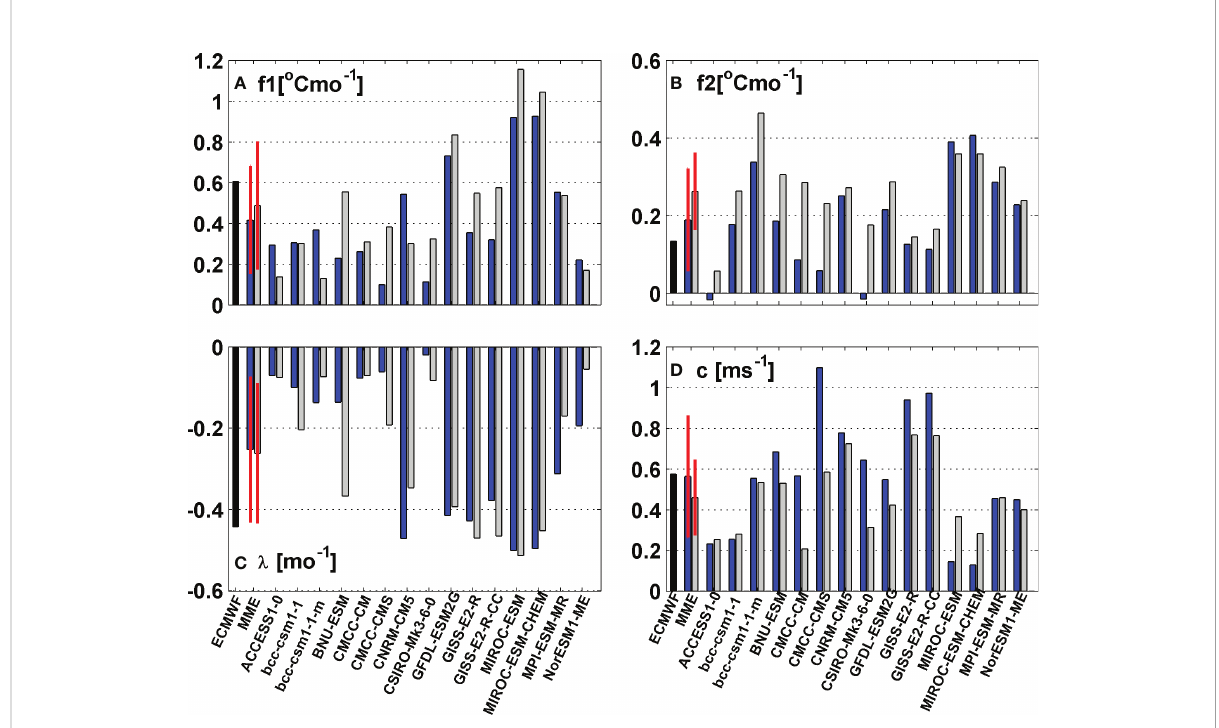
FIGURE 5 (A) Annual and (B) semi-annual external forcing (°C month -1 ), (C) the damping rate (month -1 ) and (D) the westward propagation speed (m/s) based on ECMWF reanalysis dataset (black bars), MME and each of 15 models in the historical period (blue bars) and RCP4.5 scenario (grey bars). Red lines represent the inter-model standard